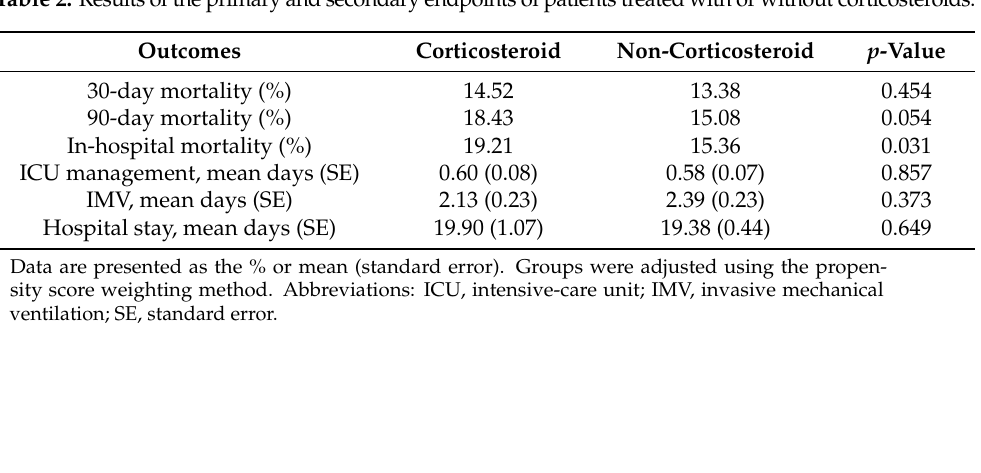
Table 2. Results of the primary and secondary endpoints of patients treated with or without